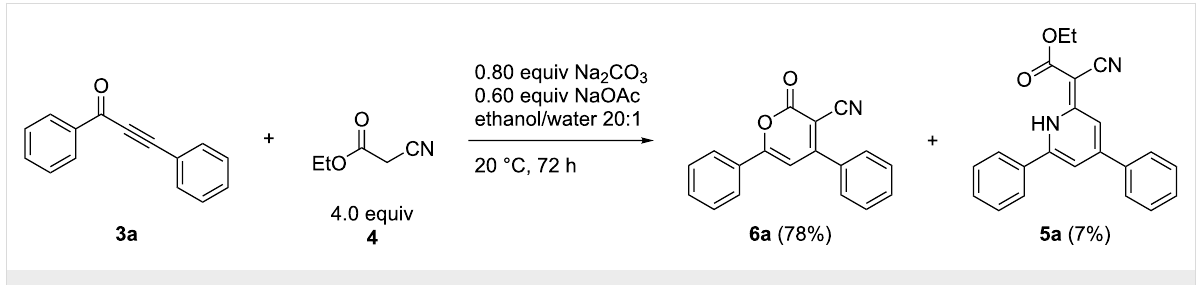
Scheme 5: Formation of α -pyrone 6a and 1 H -pyridine 5a at 20 °C.